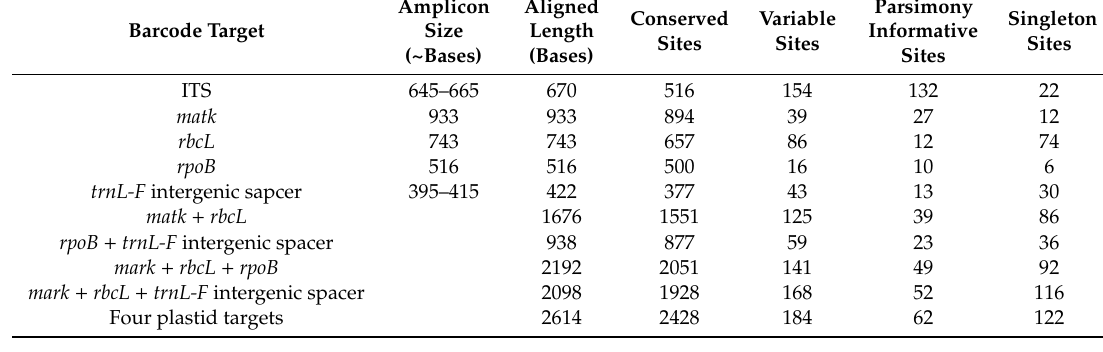
Table 2. Amplicon size of plastid loci and nuclear barcode region in Amomi Fructus and adulterant species and the sequence characteristic, single and in di ff erent multi-region combination.